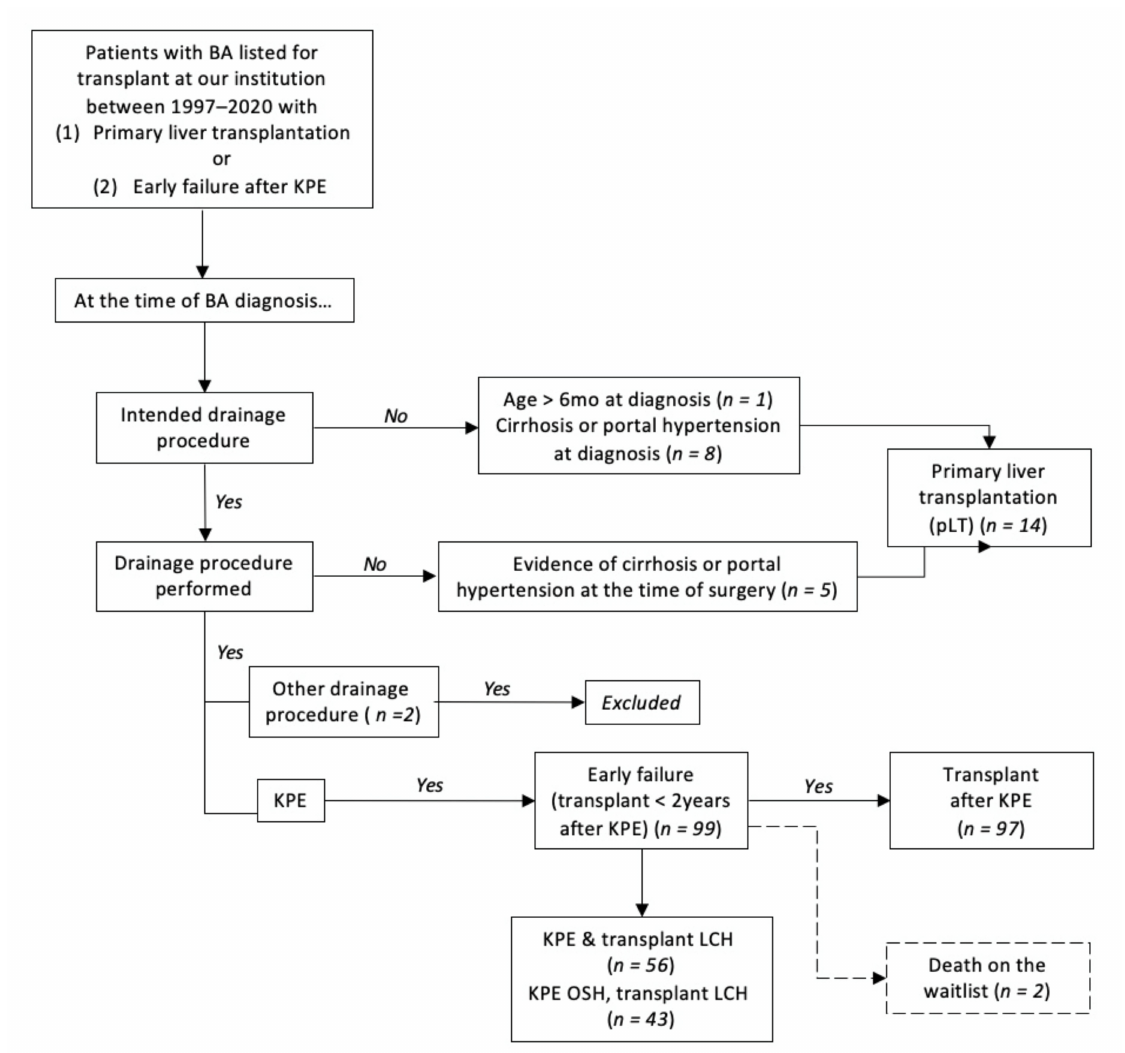
Figure 1. Flowchart describing patient selection (legend: BA: biliary atresia; KPE: Kasai portoenteros- tomy; LCH: Lurie Children’s Hospital; OSH: Outside hospital; pLT: Primary liver